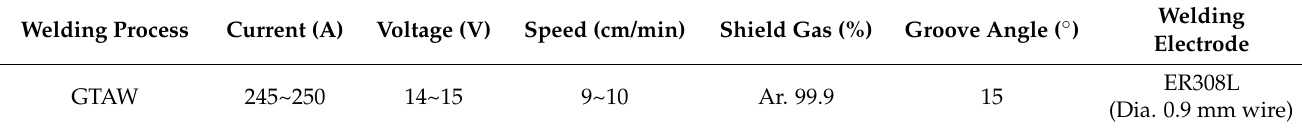
Table 2. Welding conditions of the experimental